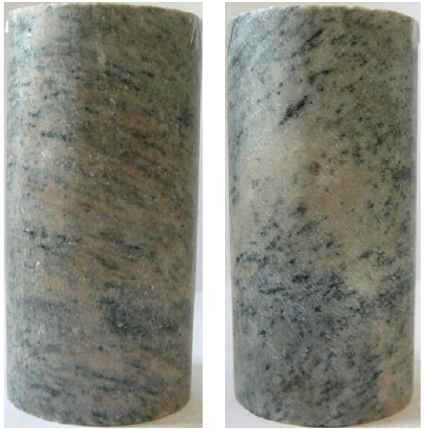
Figure 2: Typical rock specimens of granite